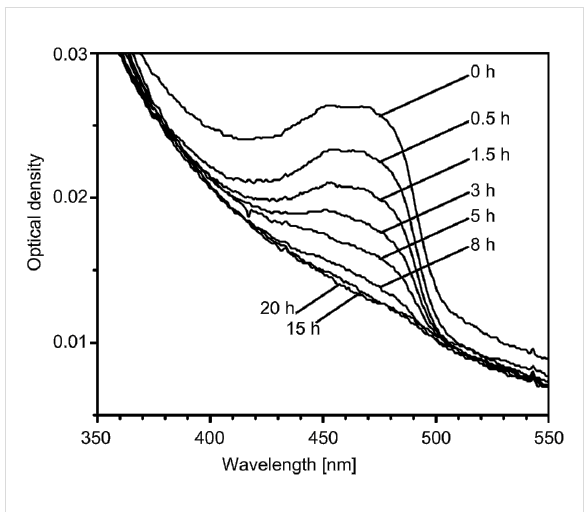
Figure 2: UV–vis spectra of MCQ/S film after irradiation in a carousel apparatus for the indicated periods.